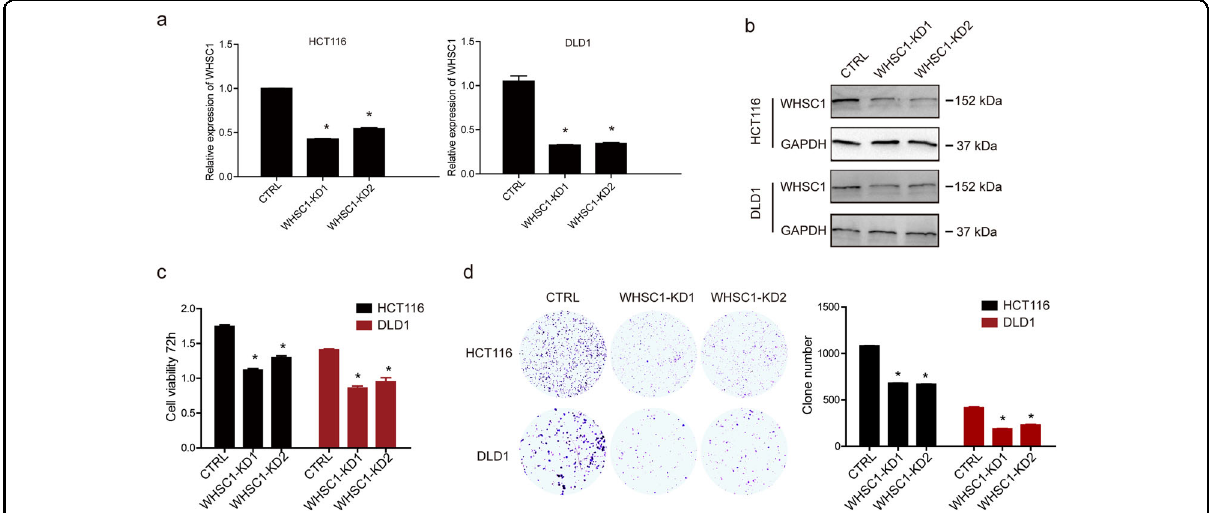
Fig. 2 Knock down WHSC1 inhibits tumorigenesis in CRC cells. a qPCR analysis of the indicated mRNA in control and WHSC1 knockdown cell lines. b Immunoblotting analysis of WHSC1 in DLD-1 and HCT116 cells transduced with two speci fi c shRNA. c , d CCK-8 assays ( c ) and colony formation assays ( d ) in parental and WHSC1 knock down cells. The quantitation results are shown in the right